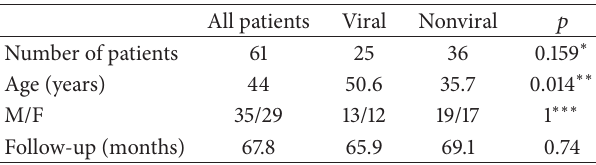
Table 2: Demographic characteristics of patients in viral and nonviral group.